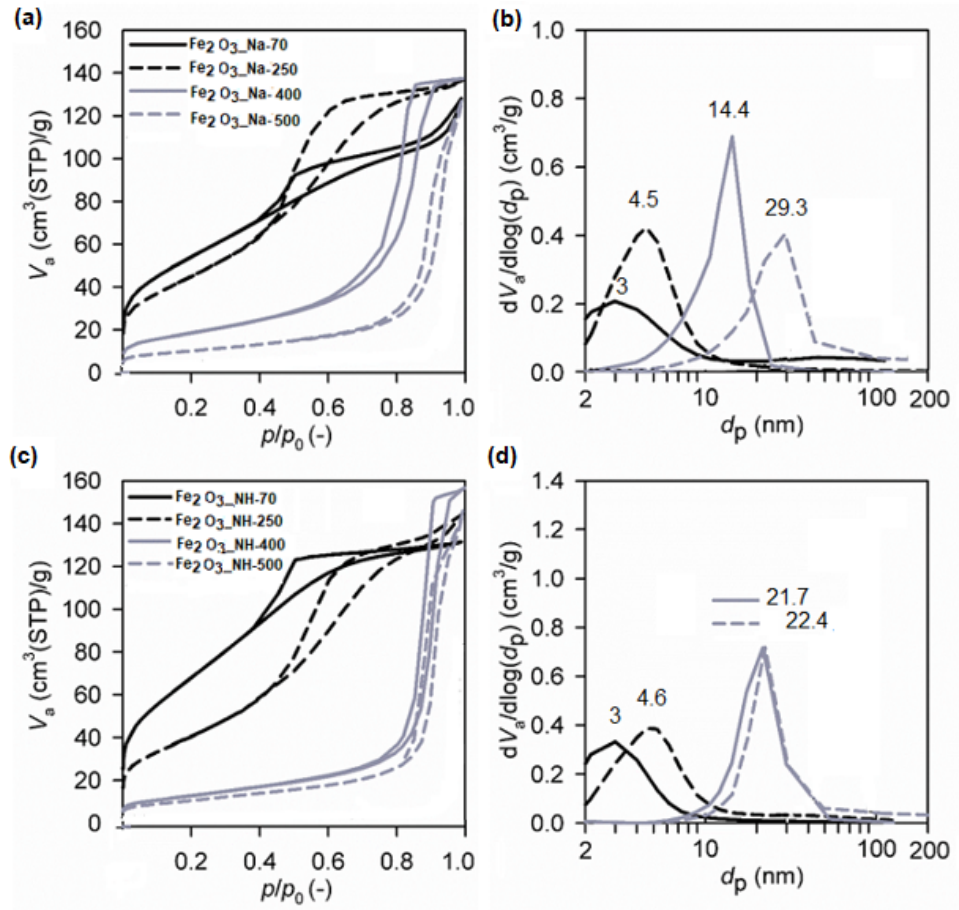
Figure 9. Measured nitrogen adsorption-desorption isotherms and evaluated pore size distributions of Fe 2 O 3 nanoparticles prepared using the precipitators and calcined at different temperatures: NaOH ( a , b ) and NH 4 OH ( c , d